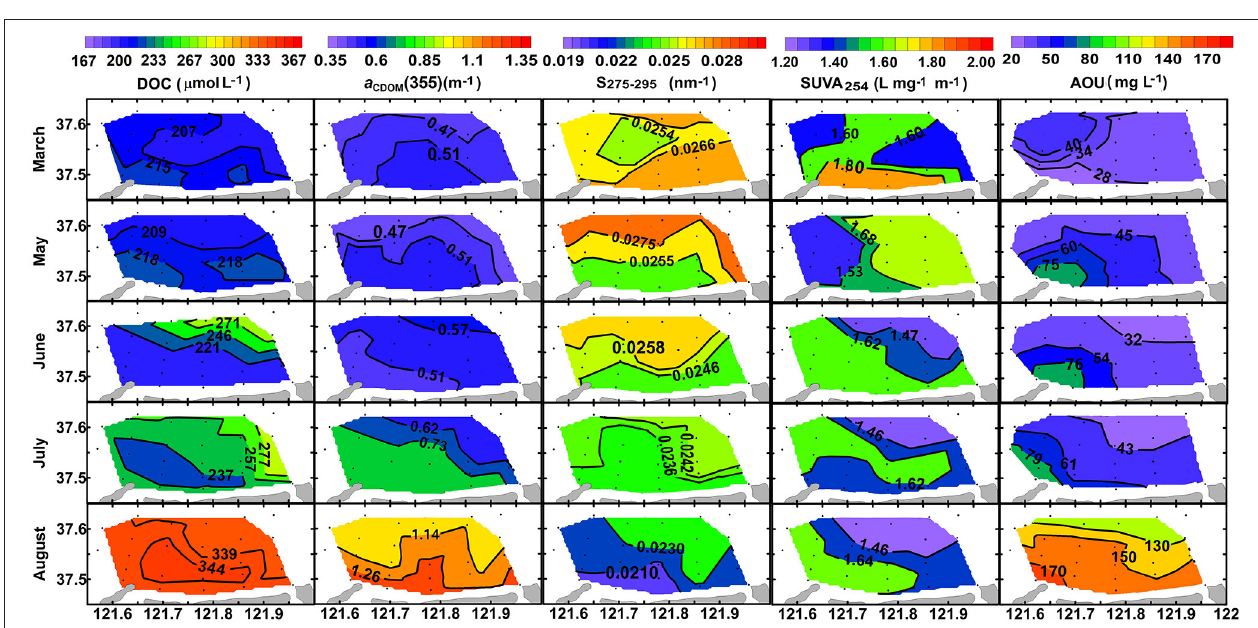
FIGURE 6 | Horizontal distributions of [DOC] in µ mol L − 1 , a CDOM (355) in m − 1 , S 275 − 295 in nm − 1 , SUVA 254 in L mg − 1 m − 1 , and AOU in mgL − 1 in the bottom layer from March to August of